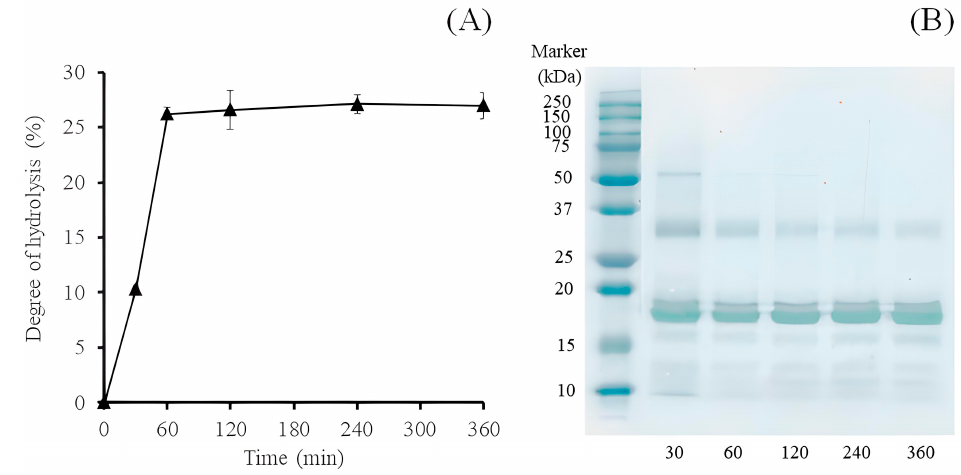
Figure 1. Degree of hydrolysis (%) of the hydrolysates from DBSC after the action of Flavourzyme for 360 min ( A ). SDS-PAGE analysis of SPH with Flavourzyme ( B ).